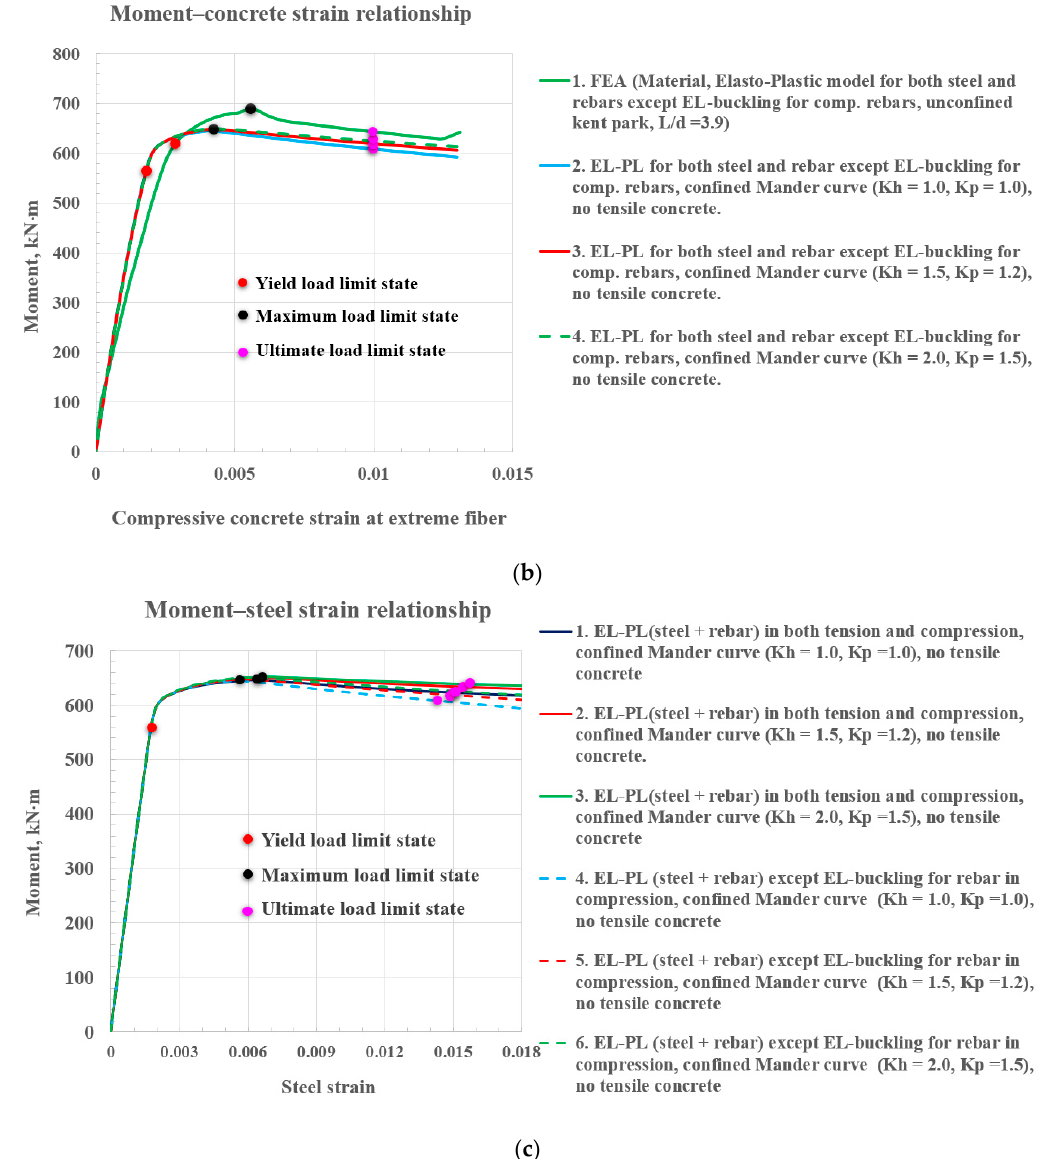
Figure 11. Parameters influencing the flexural strength of the steel section encased in structural concrete; finite element analysis compared with test data; moment–compressive concrete strain relationship based on tie models with fixed base (with base vs. without base): ( a ) Moment–compressive concrete strain relationship; ( b ) moment–compressive concrete strain relationship with buckling for rebar in compression; ( c ) moment–tensile steel strain relationship.